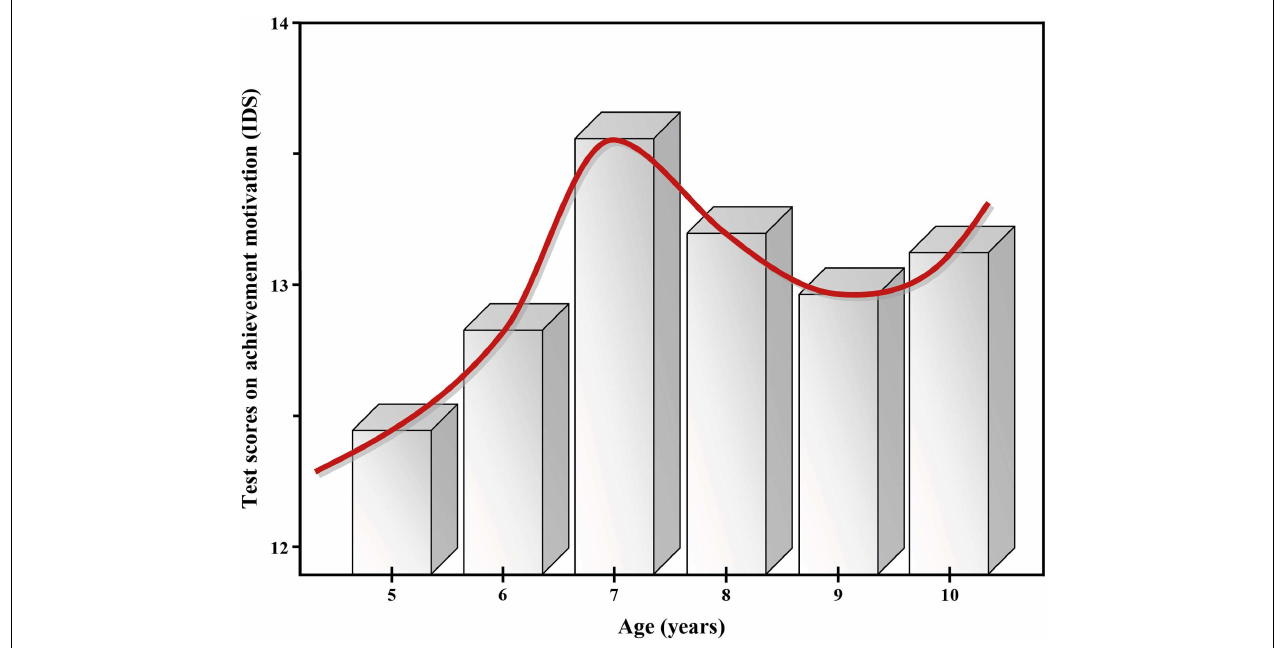
FIGURE 1 | Mean test scores on the IDS subscale “achievement motivation” changing with age: an example of a true U-shaped development between 7 and 10years of age?